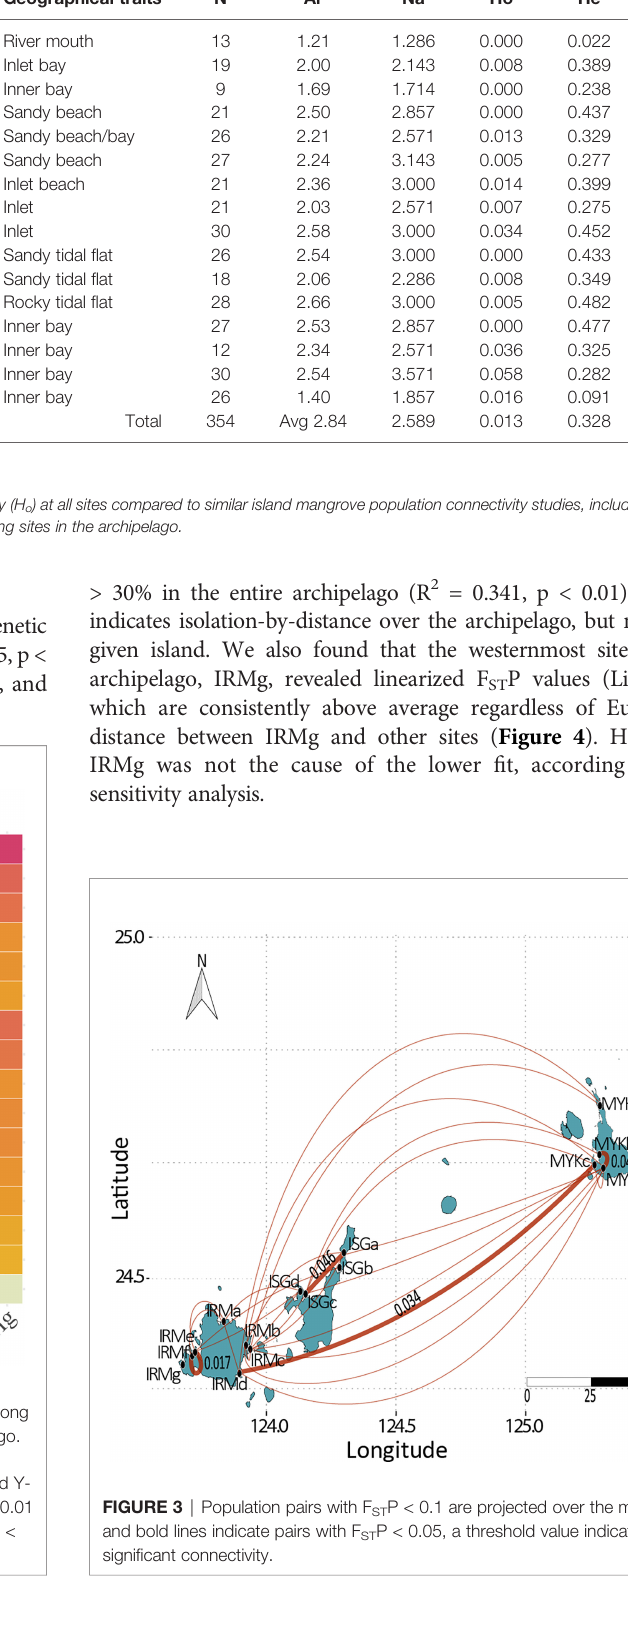
TABLE 1 | Sampling site information and genetic variability of each site. Island Population Okinawa